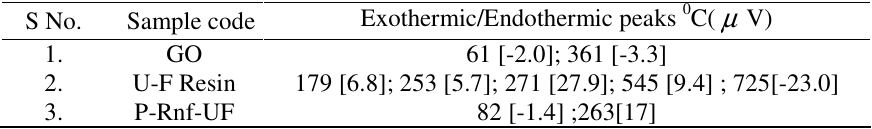
Table 1. Thermogravimetric analysis of UF, GO and P-Rnf-UF composites S